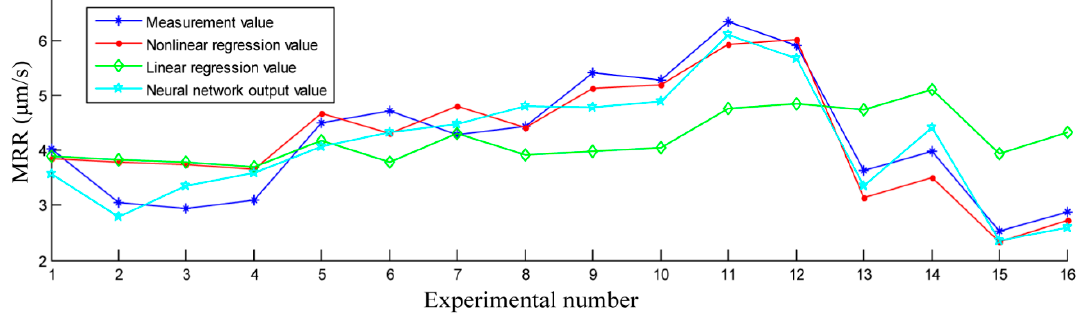
Figure 3. Comparison of measured MRR values and the corresponding prediction values of the three models for the sixteen experimental datasets.